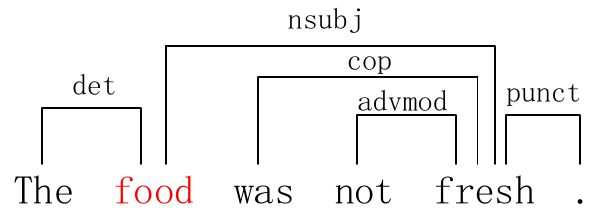
Figure 3. Dependency syntax example 2.